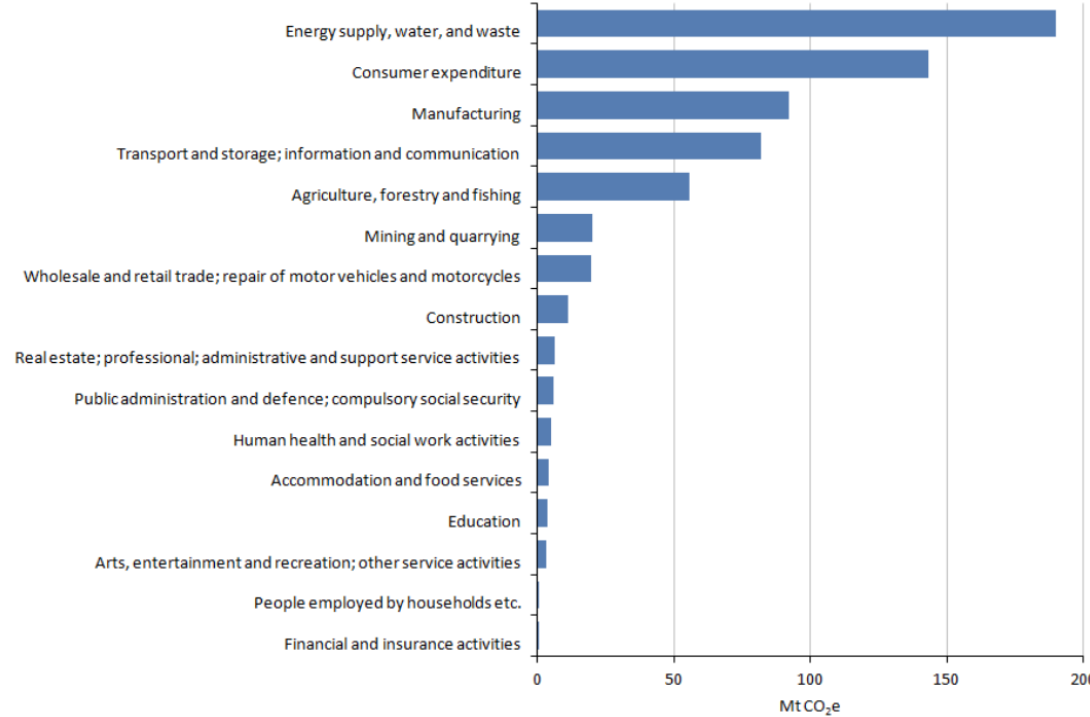
Figure 1. Greenhouse gas emissions by economic sector, 2013. UK residency basis. (Source: Ricardo-AEA, Office for National Statistics).